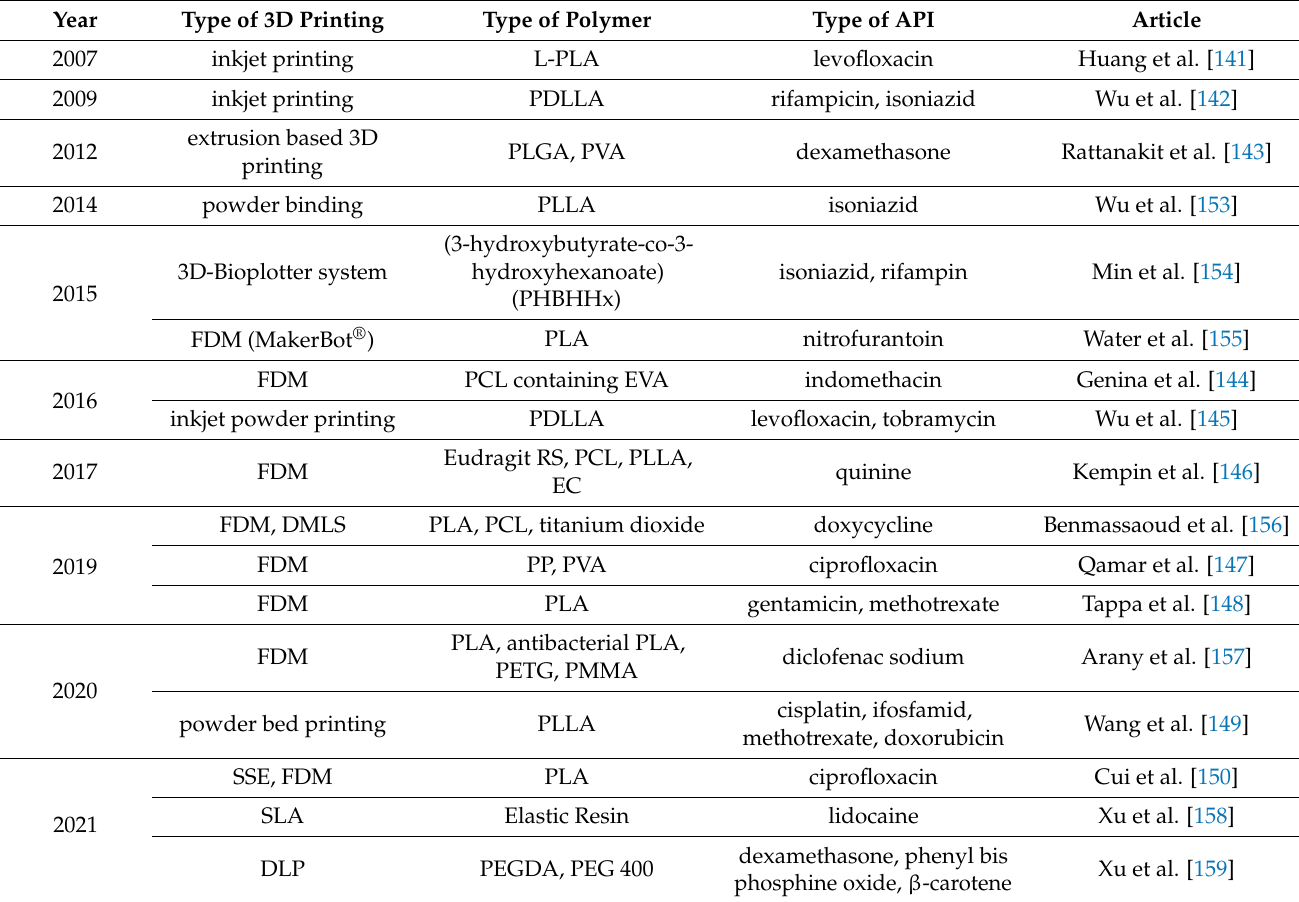
Table 5. The grouping of the manufactured implants based on the publication year and then in alphabetical